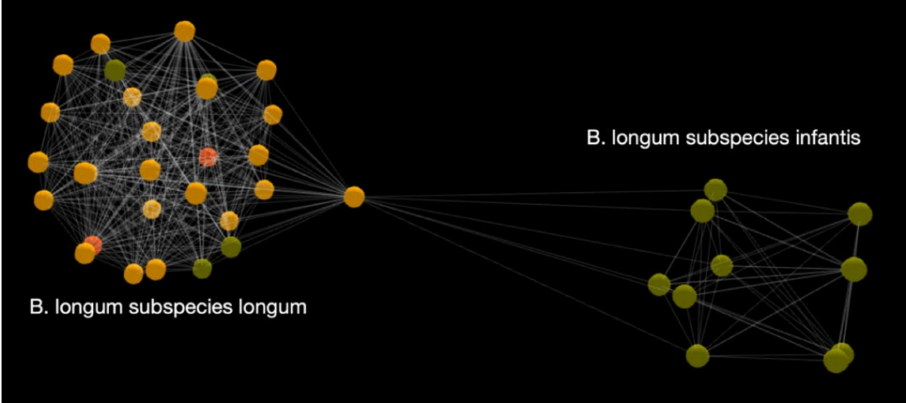
Figure 7. A genetic map of B. longum subspecies.